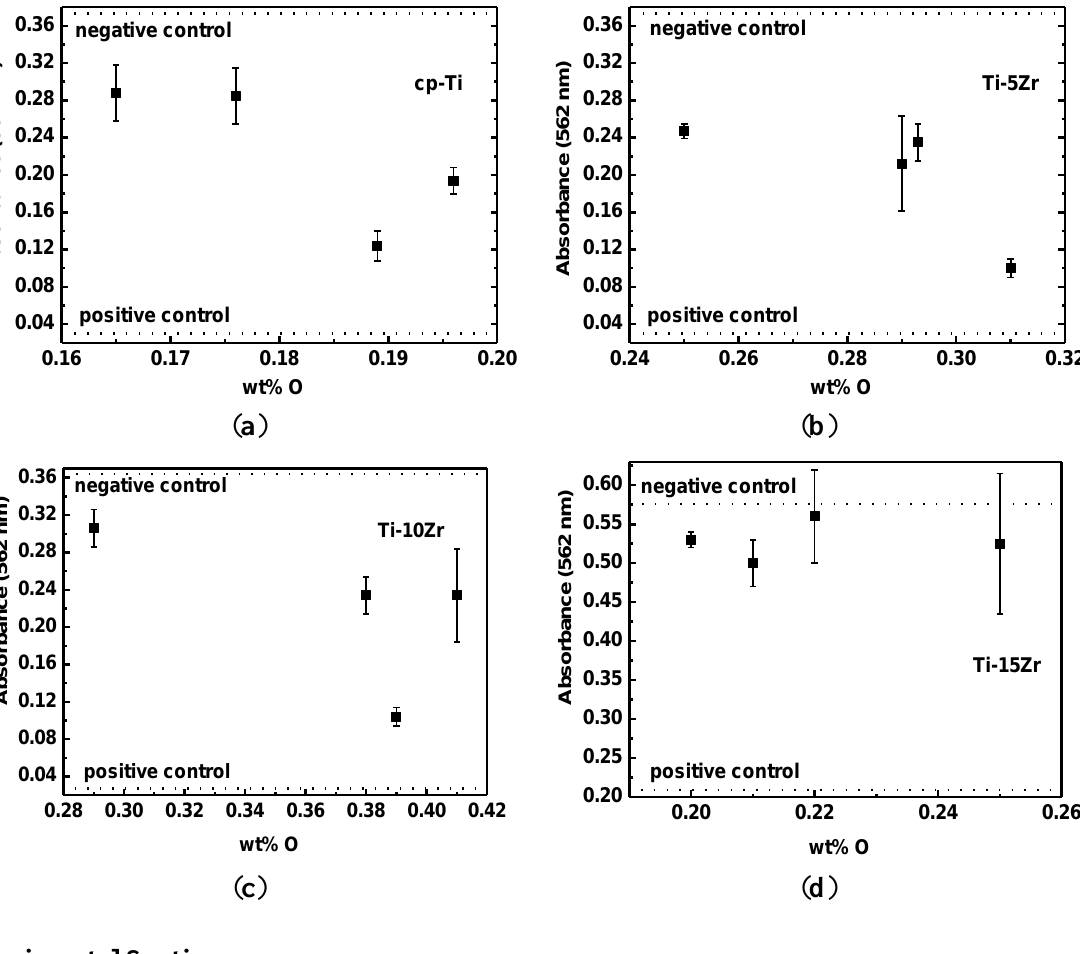
Figure 6. Direct cytotoxicity tests as a function of the oxygen concentration for ( a )